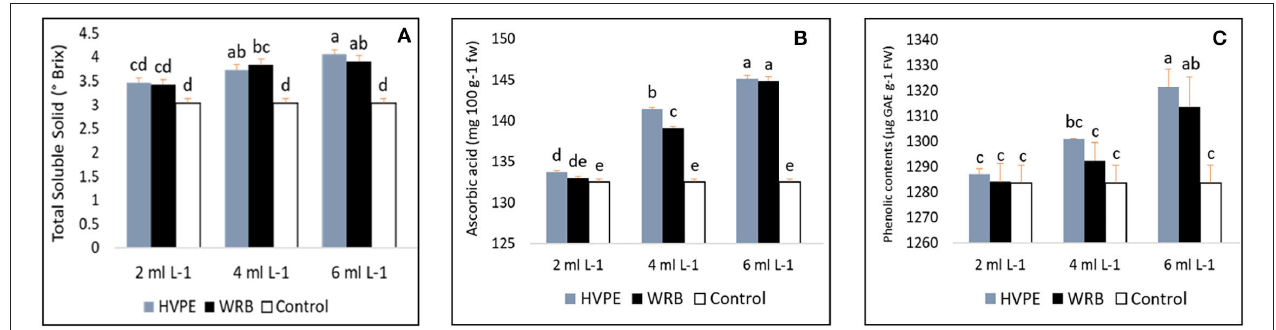
FIGURE 4 | Total soluble solids, ascorbic acid, and the total phenolic content (A–C) of bell pepper untreated plants (Tr0), treated with 2mL L − 1 (HVPE-1), 4mL L − 1 (HVPE-2), 6mL L − 1 (HVPE-3) of the Roholtiella sp HVPE. Additionally, with 2mL L − 1 (WRB-1), 4mL L − 1 (WRB-2), 6 mL L-1 (WRB-3) of the Roholtiella sp WRB. Total Soluble Solid (A) ; Ascorbic Acid (B) ; Phenolic Content (C)